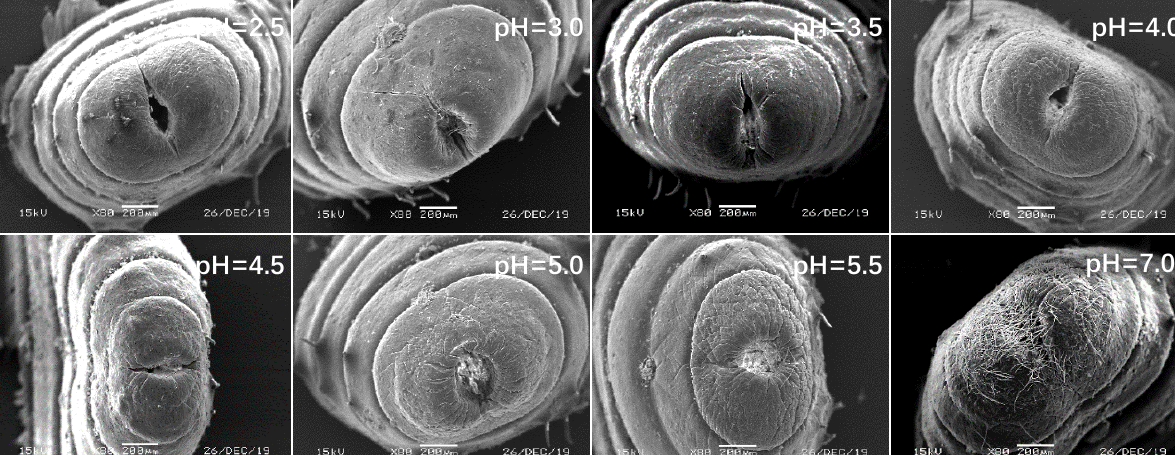
Figure 10. Anus of adult Eisenia fetida on filter paper under acid rain with eight pH levels for 72 h ( n = 10). Treatments: pH 7.0: control, pH 2.0–5.5: acid rain with different pH levels.